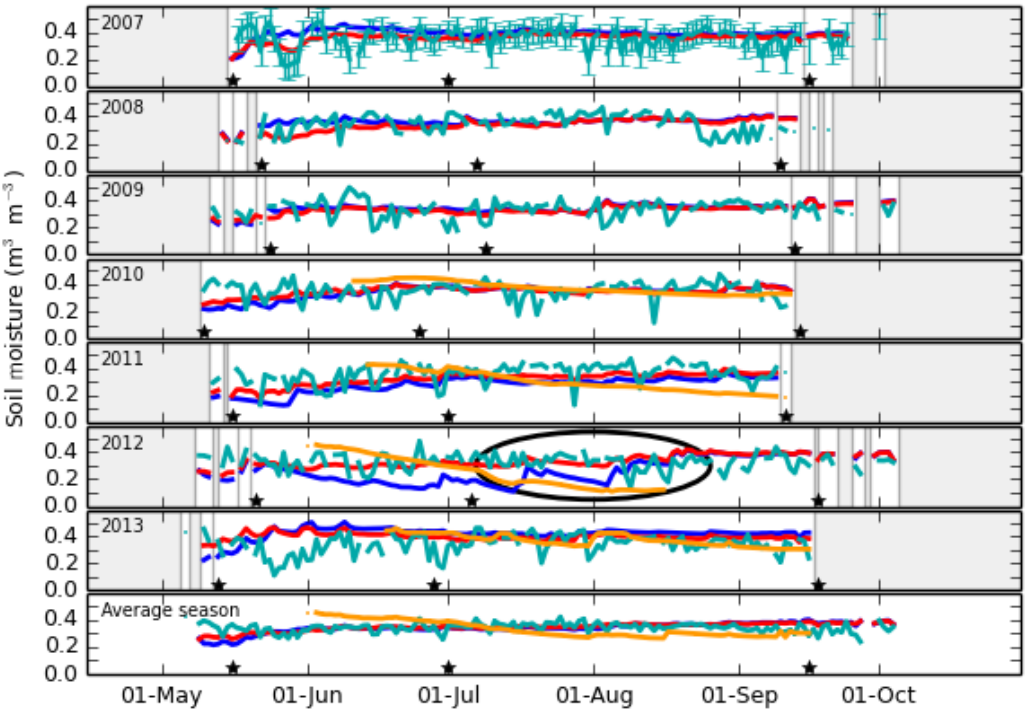
Figure 8. As Fig. 5, but for the Elgeeii